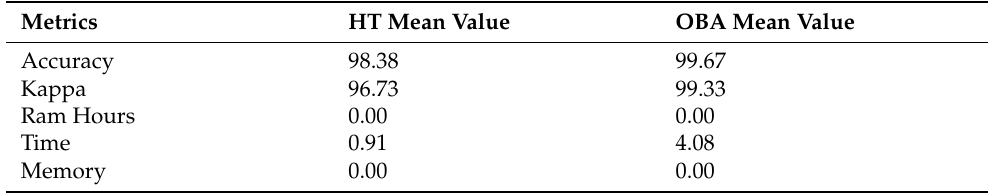
Table 2. Hoeffding tree (HT) and OzaBagAdwin (OBA) binary classification results.